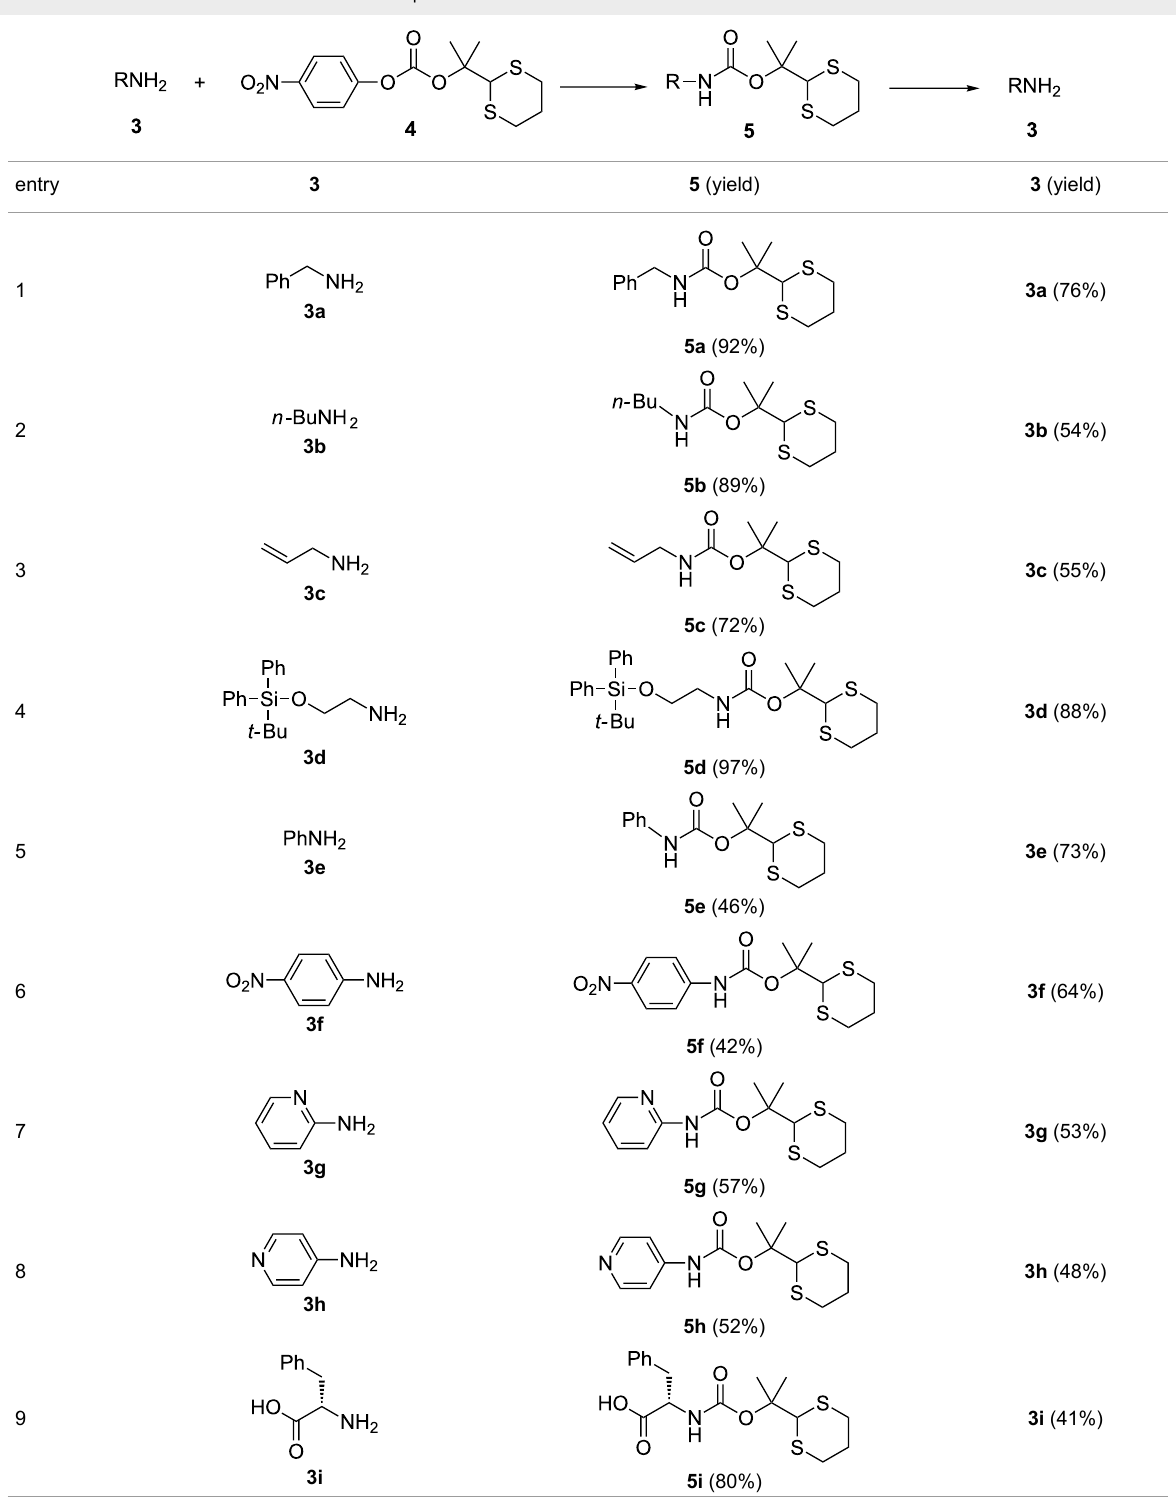
Table 1: Protection of amines with dM-Dmoc and deprotection.